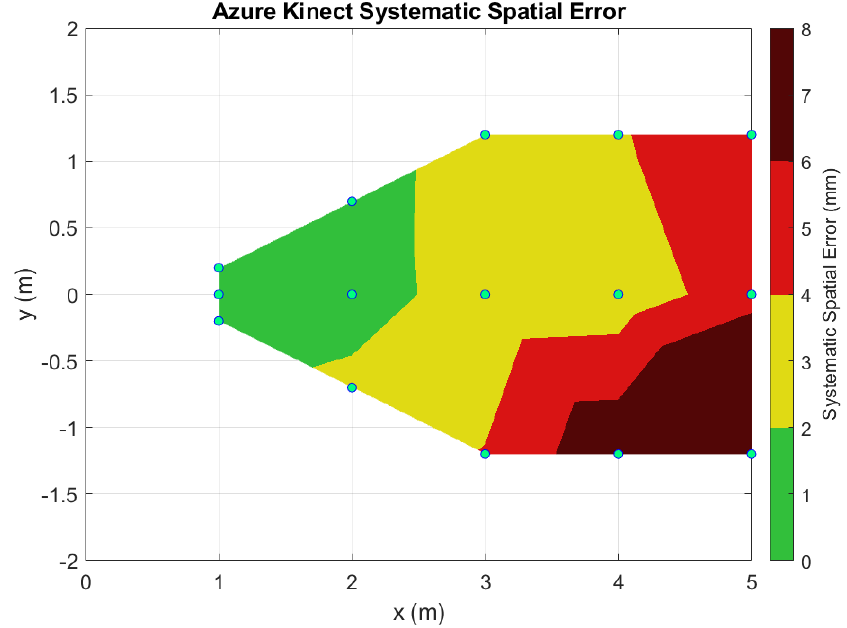
Figure 13. Contour plot of the systematic spatial error over the horizontal plane for the Kinect v2 sensor.